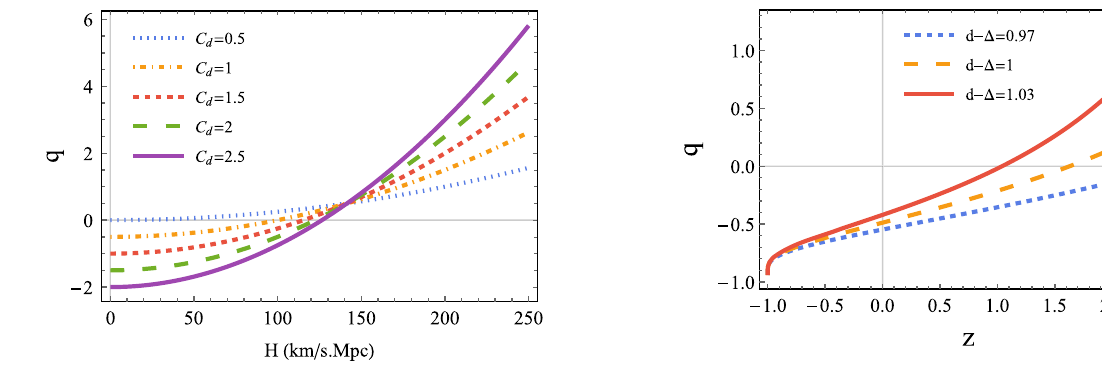
Fig. 2 Deceleration parameter q versus Hubble parameter H for five different values of C d , D d ,Δ = 0 . 00005, and d − Δ = 2. Notice the change of sign